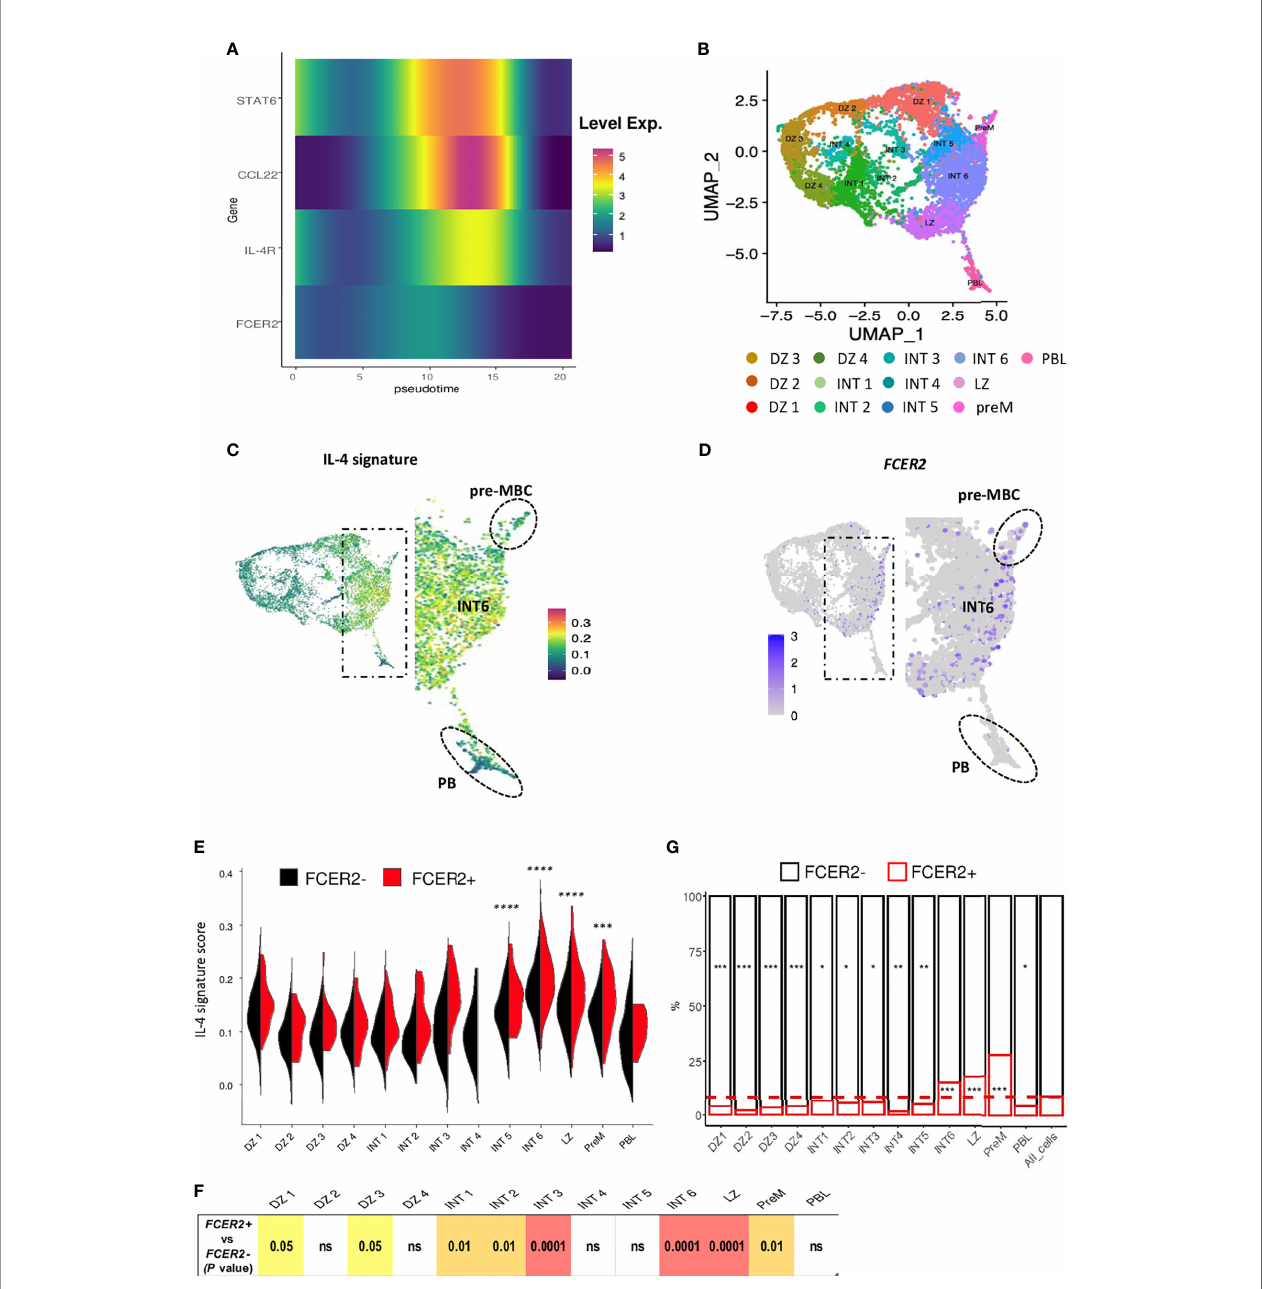
FIGURE 7 | Overview of the IL-4 signature in LZ B GC -cells. (A) The time course of expression of IL-4-induced genes by quadrant showing a difference between the almost fl at FCER2 expression and the strong CCL22 expression. (B – G) Single-cell RNA-seq data for human tonsil-derived total B GC -cells, from Holmes et al., 2020 . (B) UMAP representation of the 13 speci fi c clusters de fi ned by Holmes et al. ( C ) UMAP showing cell expression of the IL-4 signature, noteworthy that positive cells are located in the right part of the map mainly in intermediate 6 (INT6) cluster (enlarged view) with an expression maintained in pre-MBCs (Top, dotted circle) while PBs are negative (Bottom, dotted circle). (D) UMAP showing FCER2 + cells; the enlarged view shows the preferential enrichment of these cells on the far right of the map depicting a ridge line extending from the INT6 cluster to the pre-MBC cluster (top, dotted line circle). (E) Violin plots comparing IL-4 signature expression in each of the 13 GC B cell clusters for FCER2 + (red) and FCER2 - (black) cells (Pairwise t-test for IL-4 signature comparison between clusters is indicated above the plot; *** P < .001; **** P < .0001). (F) Table of P values of Wilcox test comparing FCER2 + and FCER2 - B GC -cells for IL-4 signature in each of the 13 clusters. (G) Percentage of FCER2 + and FCER2 - B GC -cells in the 13 clusters. Dotted line represent the mean value of positive cells for all clusters (last barplot named All_cells). Chi2 test for each population compared to total cells (*p < 0.05, **p < 0.01, ***p < 0.001, "ns" for non signi fi cant); signi fi cant test are indicated in the barplot of enriched FCER2 neg or pos populations